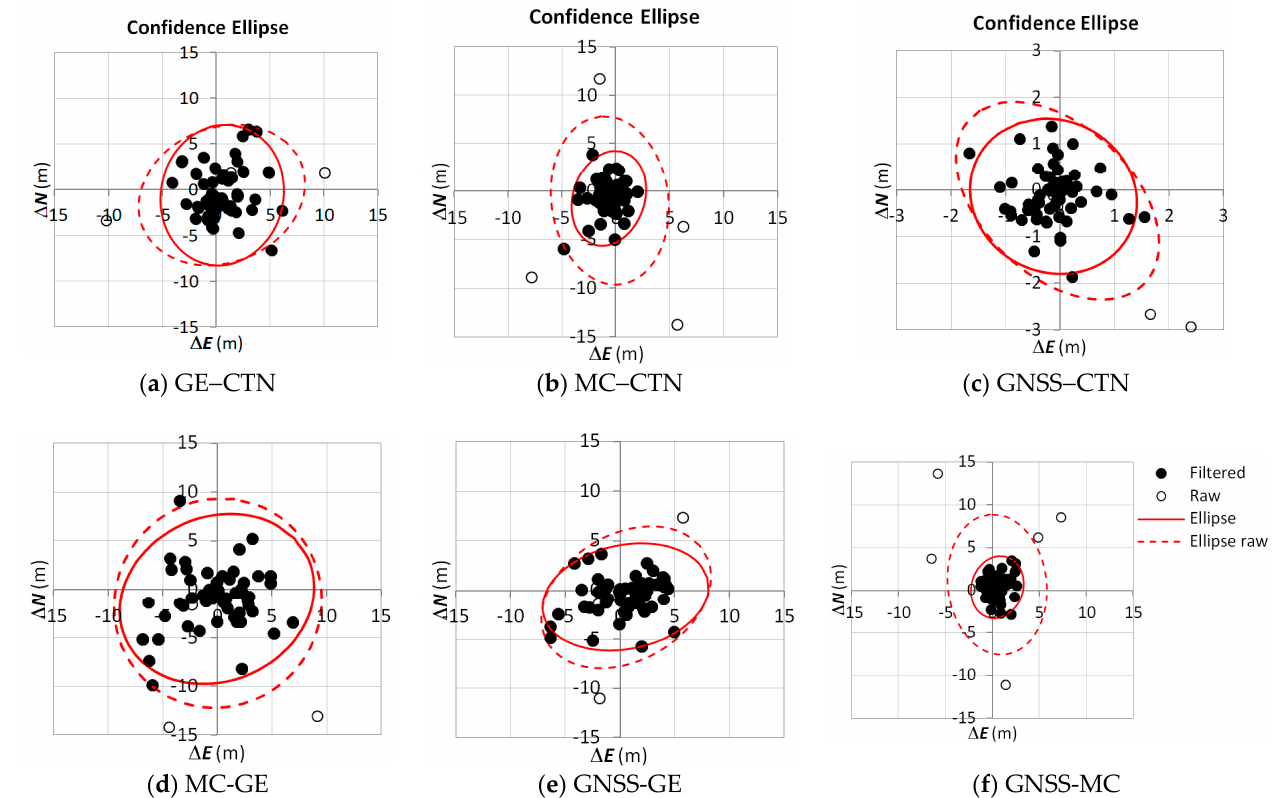
Figure 6. Graphical verification of the bivariate normal distribution: confidence ellipses pre- and after outliers’ removal (dashed red line and continuous red line, respectively). The confidence level for the confidence envelope is set to 0.95. Pairs (before outliers’ removal) are represented with white dots, while pairs after outliers’ removal are overimposed with black dots.